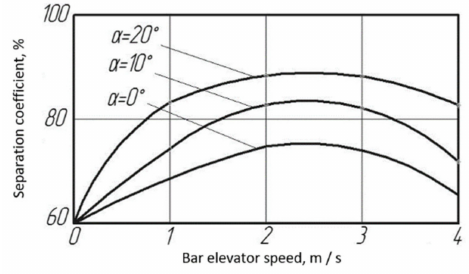
Figure 5. Graph of the separation coefficient ε of the rod elevator from the angle α of the inclination of the rod elevator and translational speed v EL [4].